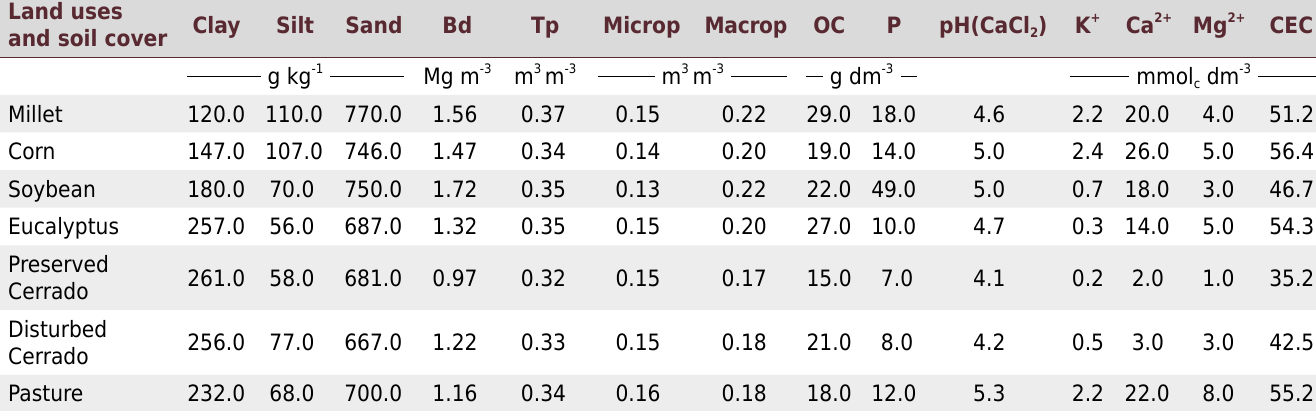
Table 1. Soil physical and chemical properties in the study areas Land uses